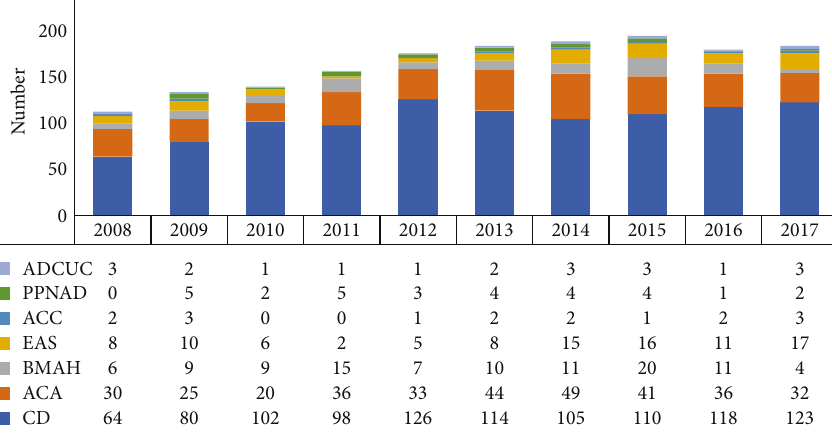
Figure 1: Time trend of CS patients by etiology from 2008 to